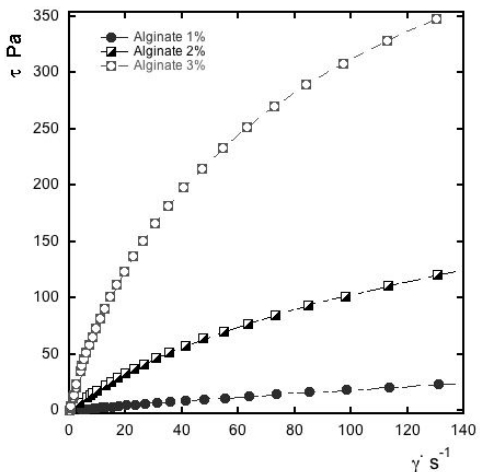
Figure 1. Flow curve of alginate at different concentrations of polymer (1, 2 and 3% w / w ) homogenized and sonicated after the addition of Tween 80 (1% w / w ).